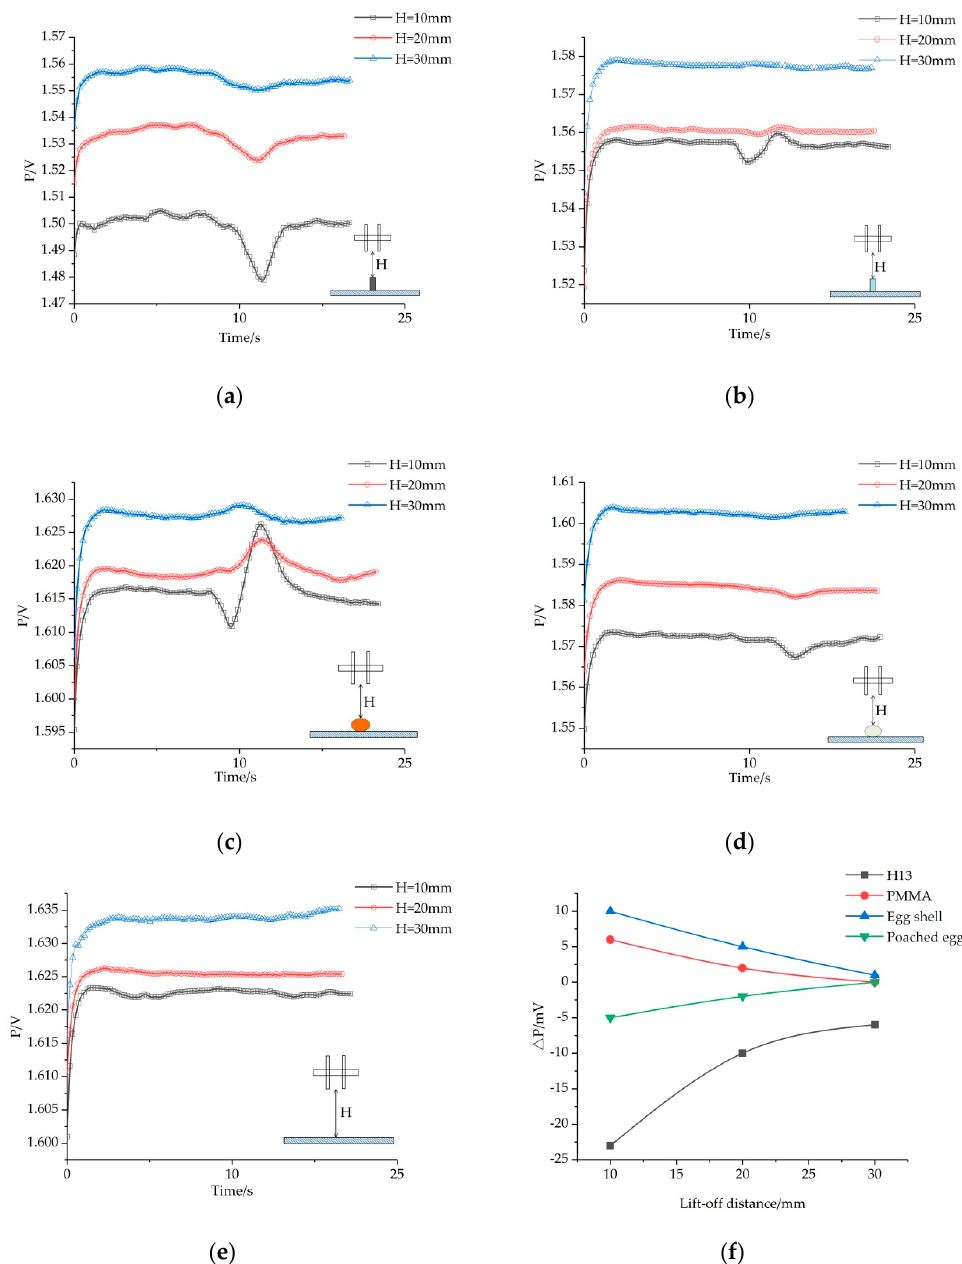
Figure 6. Effects of lift-off distance on identification performance. ( a )–( d ) Electric signal images